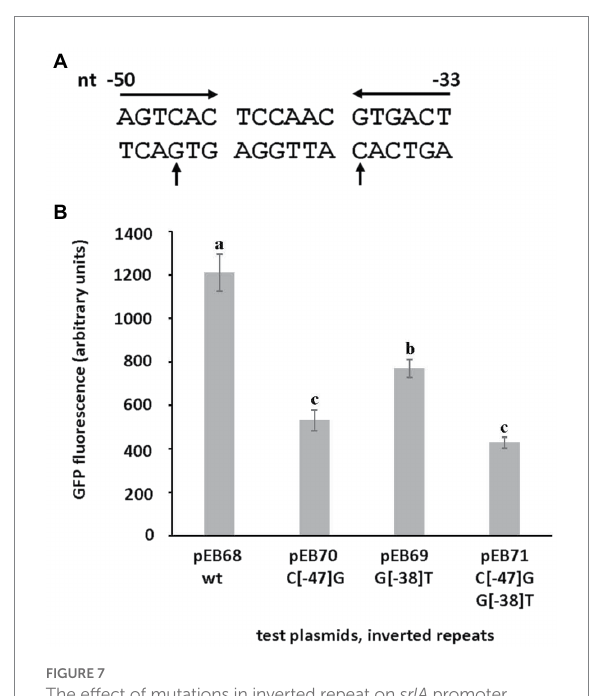
FIGURE 7 The effect of mutations in inverted repeat on srlA promoter activity. (A) srlA promoter repeat sequence (inverted arrows). Nucleotide numbering from + 1 TSS. Mutated nucleotides (C and G ) indicated (vertical arrows). (B) wt and mutant repeat srlA − 38 promoter activities in NB1854 host cells. GFP activity reported as mean ± sd, n = 3. Letters indicate whether means are significantly different ( p < 0.01, ANOVA and Tukey HSD).